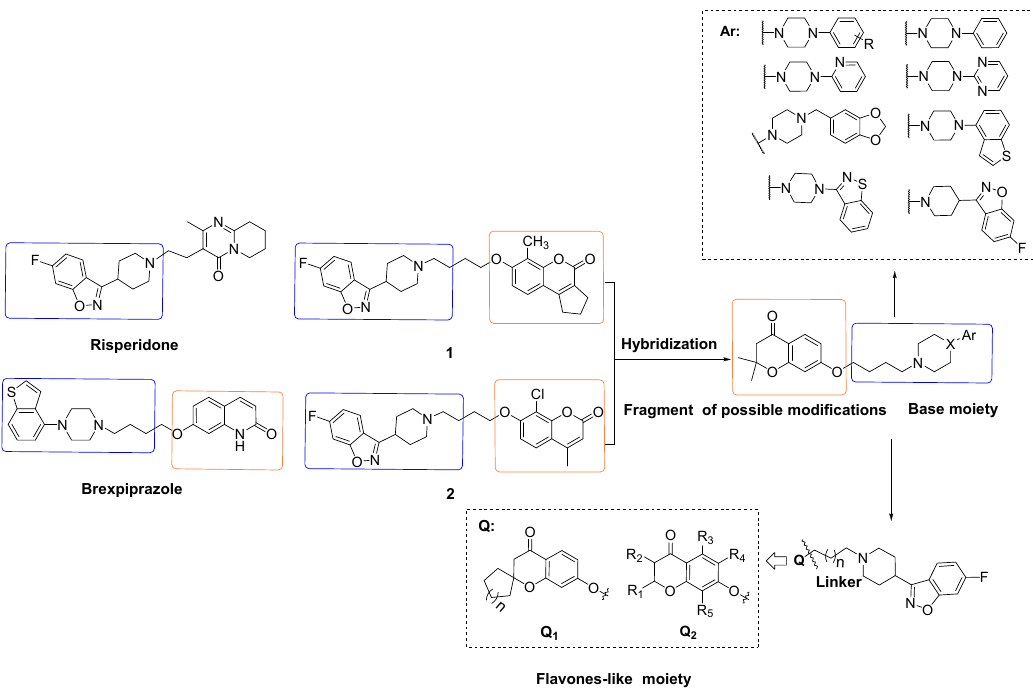
Figure 1. Design of new flavone-linker-based heterocyclic arylpiperazine(piperidine) and arylpiperazine(piperidine) derivatives.